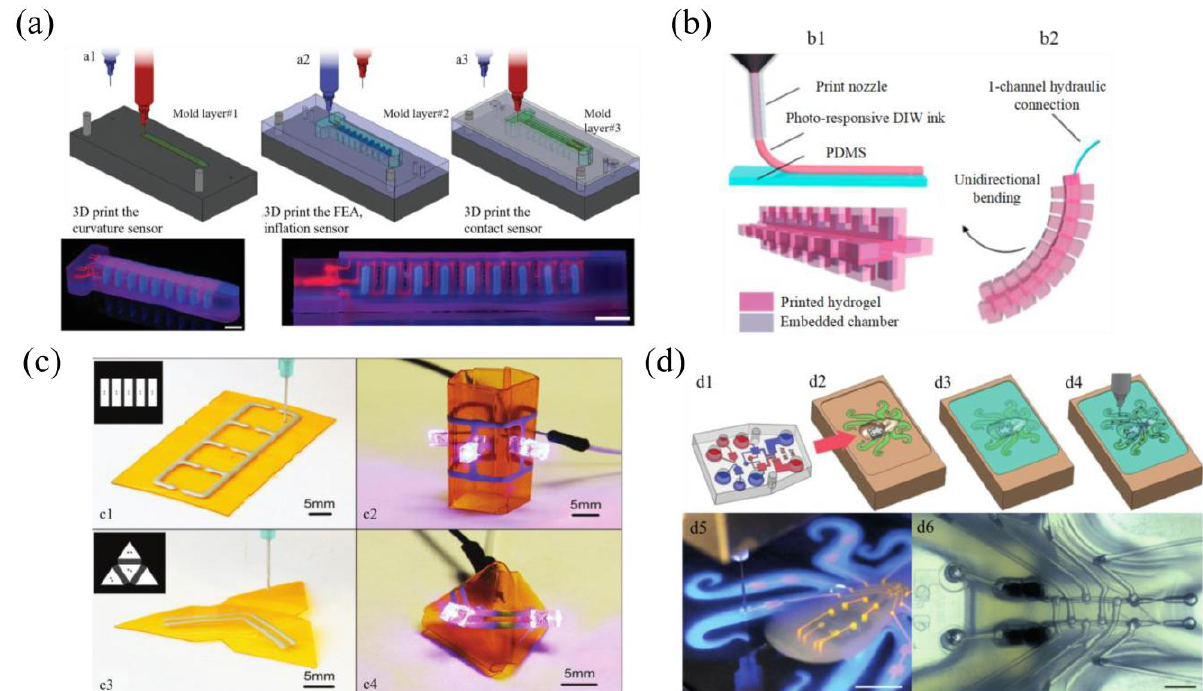
Figure 1 . ( a ) Soft sensing actuator [19]; ( b ) tentacle-like soft robot [20]; ( c ) the swollen flat shape of 3D origami structures and an LED device folded by a flat sheet [21]; ( d ) soft octopus robot [22].